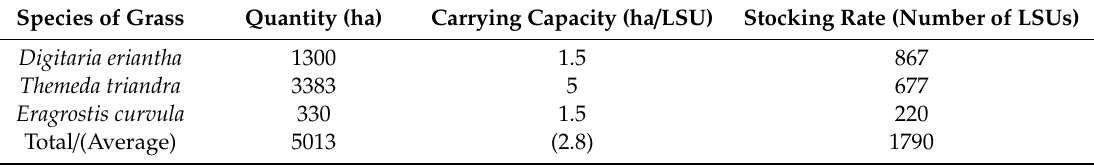
Table 2. Natural grazing composition at